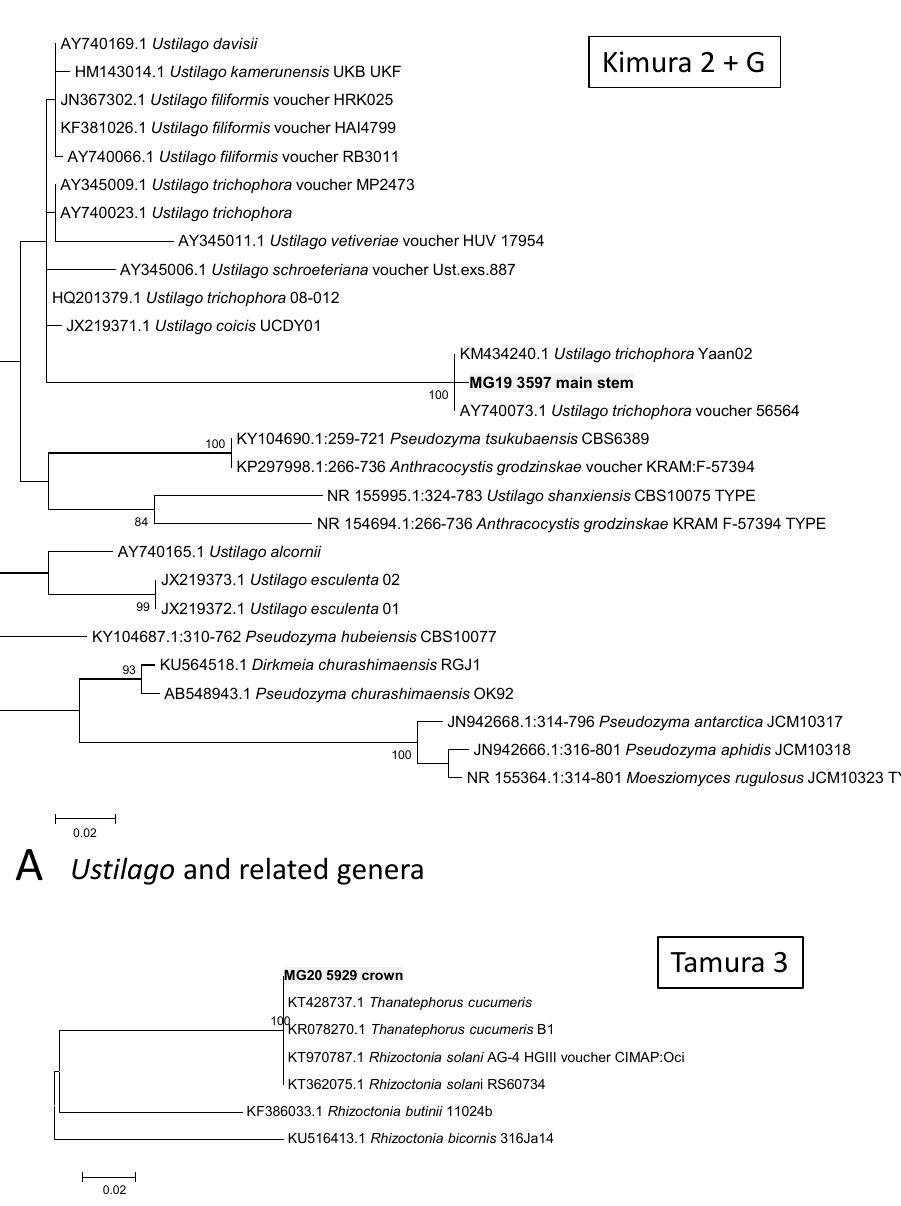
Figure 3. Phylogram of Molecular Operational Taxonomic Units assigned as Fusarium . The phylo- gram was generated with Maximum Likelihood analyses of the Internal Transcribed Spacer 2 region (used evolutionary model indicated). Confidence levels ≥ 80% (1000 replicate bootstrap analysis) are indicated on the branches. Sequence reads generated in this study are indicated with MG codes.